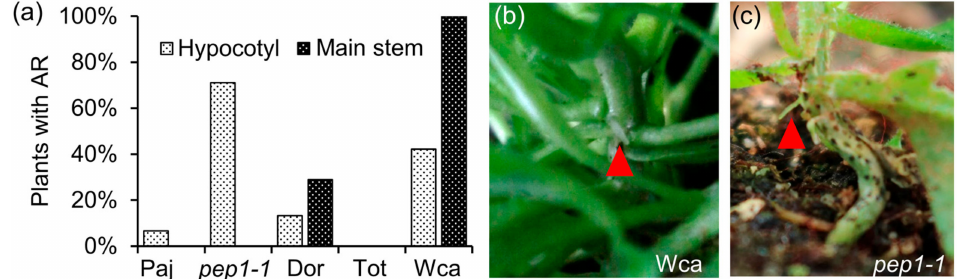
Figure 1. Natural variation for adventitious rooting in A. alpina . ( a ) Percentage of plants with adventitious roots on the hypocotyl and on the main stem in the A. alpina accessions Paj, Dor, Tot and Wca, and the pep1-1 mutant. Plants did not have adventitious roots in the axillary branches. Forty-five plants were scored for each accession. In long days, adventitious roots (red arrowhead) are indicated on the ( b ) main stem of Wca and ( c ) hypocotyl of pep1-1